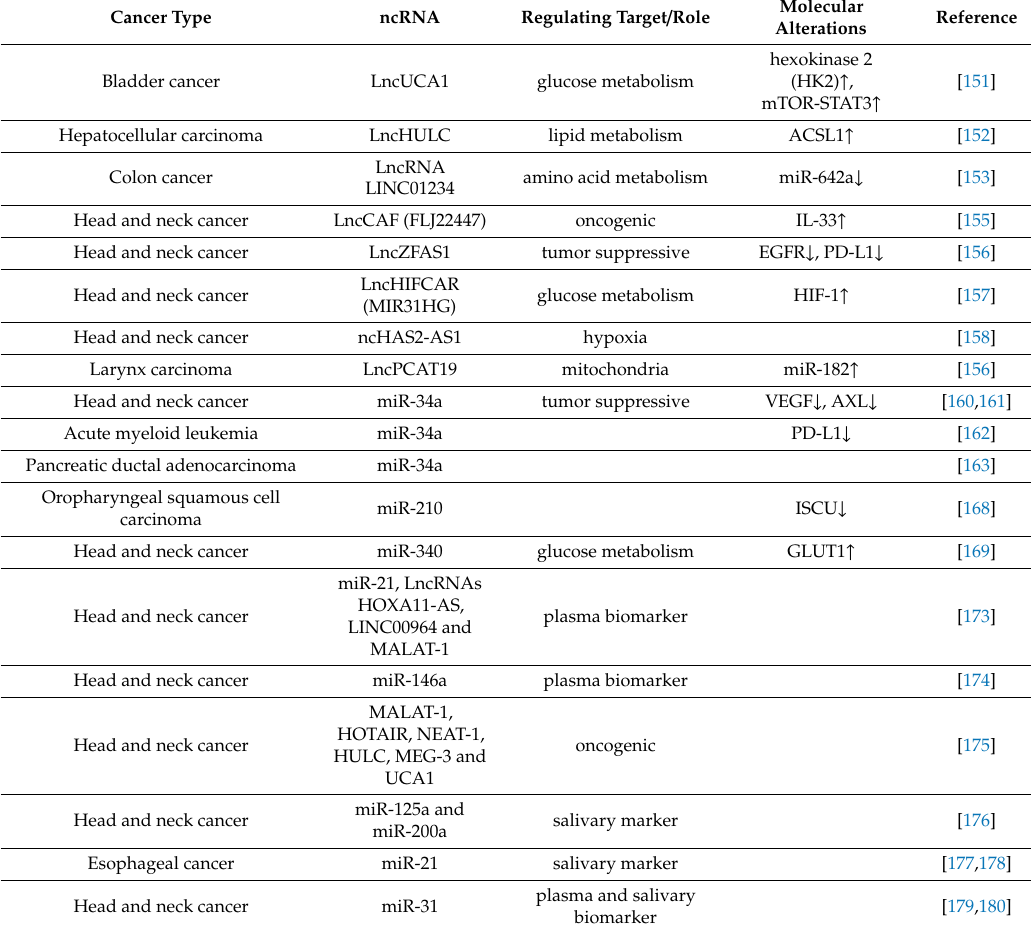
Table 1. Summary of the ncRNA-mediated regulations for the HNSCC